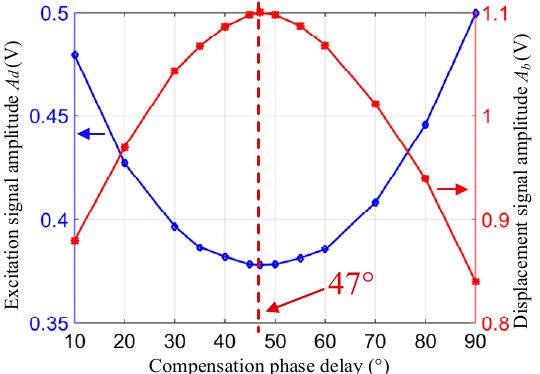
Figure 8. Influence of different compensation phase delays on the excitation signal amplitude.